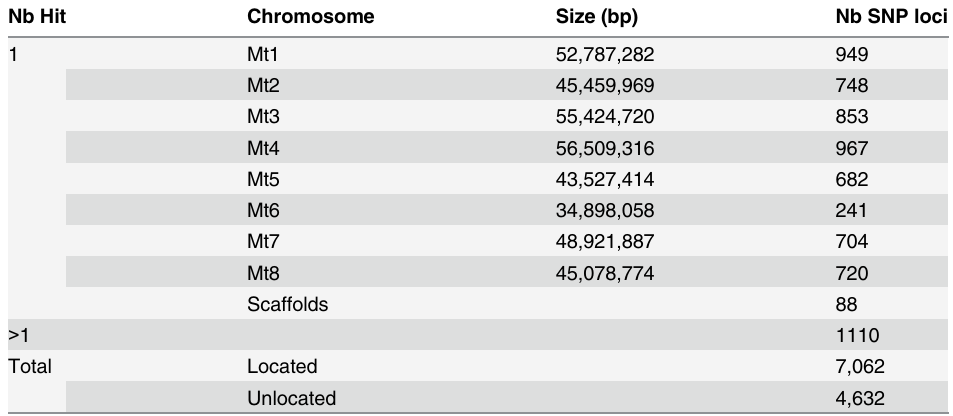
Table 4. GBS SNP loci with significant homology (E value < 1 x 10 8 ) with Medicago truncatula refer- ence genome ( v4 . 0 ). Nb Hit Chromosome Size (bp) Nb SNP loci 1 Mt1